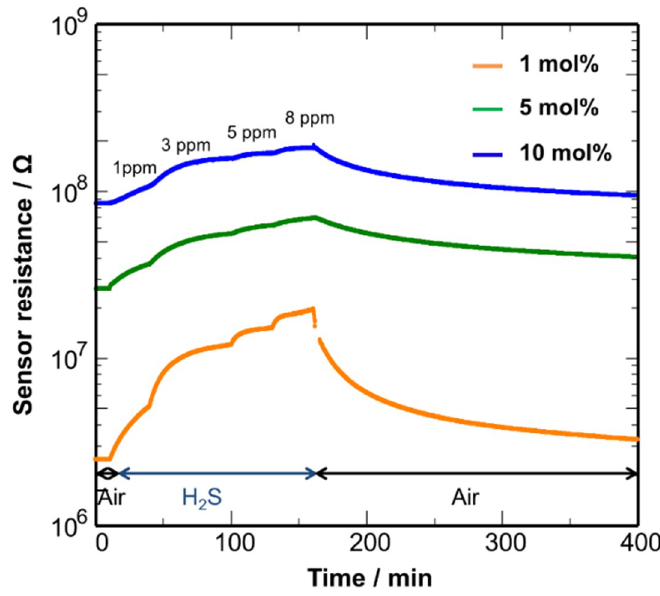
Figure 11. Response transients of the Pd (1, 5, 10 mol%)-loaded CuO NC sensor in response to 1–8 ppm H 2 S at 250 °C.